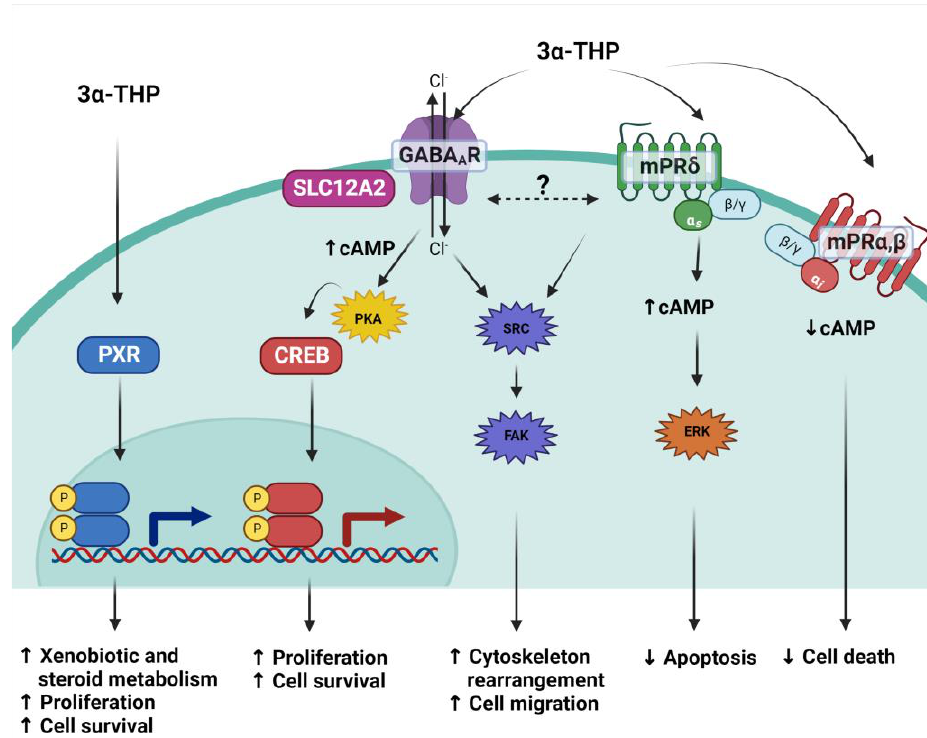
Figure 3. 3 α -THP mechanisms of action. Due to its lipophilic structure, 3 α -THP crosses the cellular membrane and directly activates the Pregnane X receptor (PXR), a transcription factor. It also modulates to the ionotropic pentamer GABA A receptor, which, depending on the expression of the cotransporter SLC12A2, induces changes in the current of chloride ions (Cl − ), augments cAMP levels and promotes the activation of the PKA kinase and the subsequent activation of the transcription factor CREB. 3 α -THP is also a ligand of the membrane P4 receptor mPR δ (green membrane receptor), a transmembrane receptor coupled to G s proteins that augments cAMP. It is hypothesized that both the latter mechanisms interact and regulate the activation of the Src/FAK pathway. Additionally, 3 α -THP also binds mPR α and mPRβ (red membrane receptor), which are coupled to G i proteins, and their activation with 3 α -THP decreases cAMP levels.